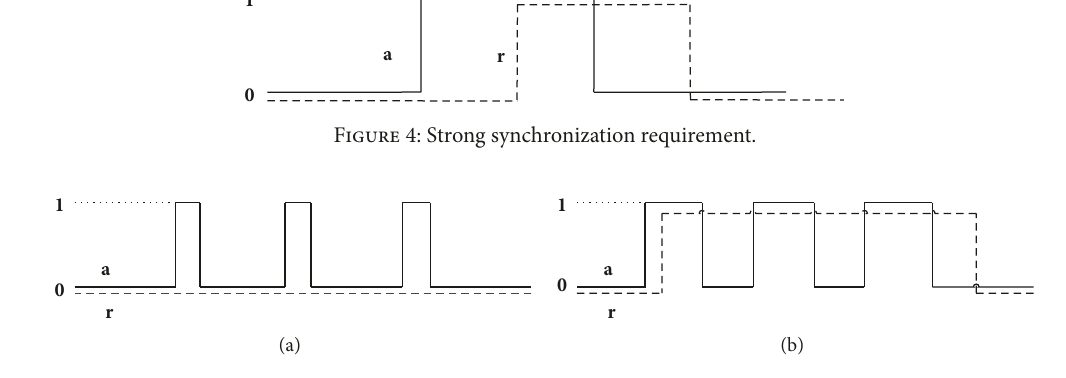
Figure 3: Actuator-reactor pattern.